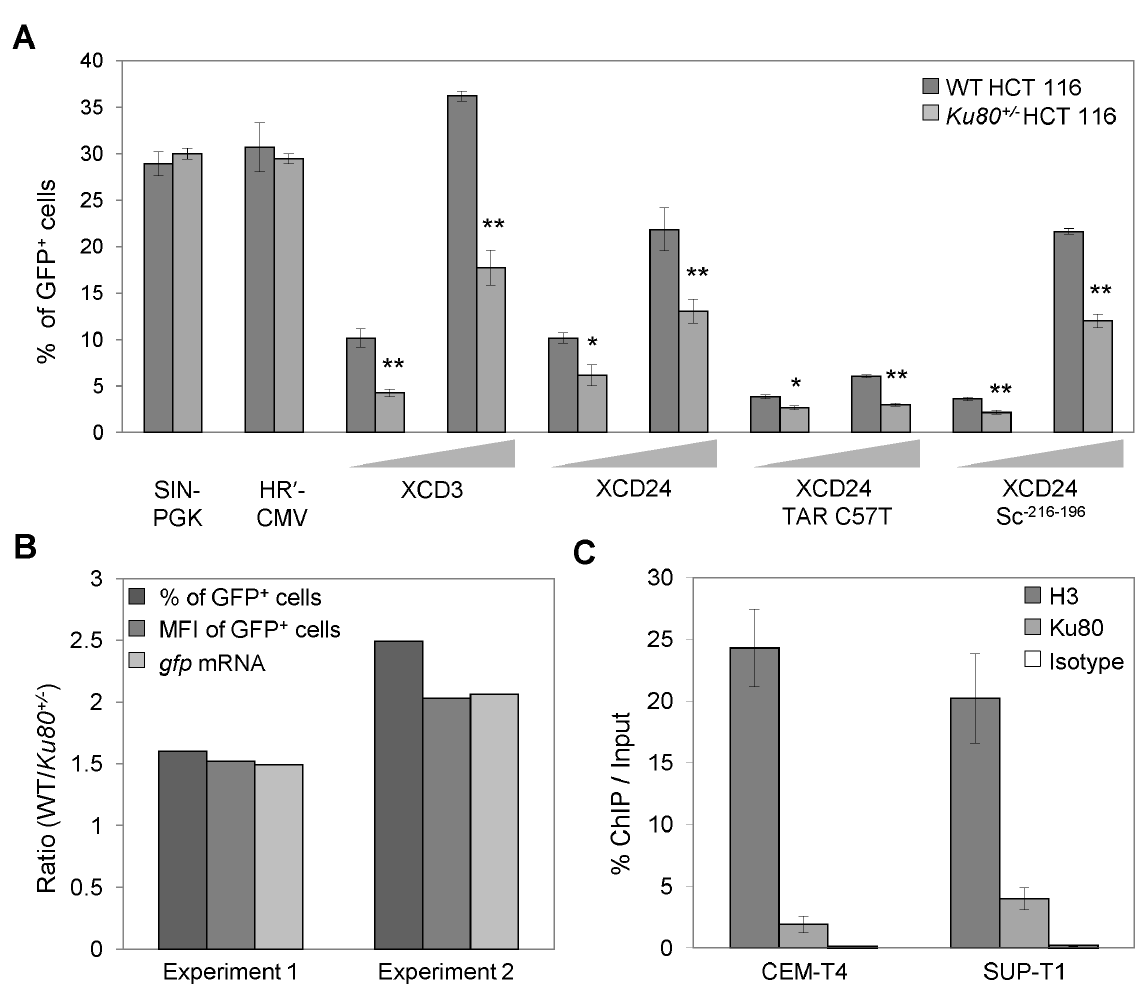
Figure 5. The level of Ku impacts specifically on the LTR-driven GFP transcription from HIV-1. ( A ) Wild-type (WT) and Ku80 + / 2 human colon carcinoma HCT 116 cells were transduced for 48 h at the depicted m.o.i. either with SIN-PGK, HR’-CMV, XCD3, XCD24 or derivatives of XCD24 in which the putative Ku-binding sequence (KBS) (XCD24 Sc -216-196 ) or the trans -activation response (TAR) RNA element [XCD24 TAR(C37T)] was mutated (for more details on vectors, refer to Figure 1 ). Thereafter, the percentage of green fluorescent protein-positive (GFP + ) cells was measured by flow cytometry. The results from at least 2 independent experiments are presented as mean 6 SEM (*, p , 0.05; **, p , 0.01), except for XCD24 Sc - 216-196 and XCD24 TAR(C37T) for which one representative experiment (of 2 independent observations yielding similar results) is represented (mean 6 SD). ( B ) WT and Ku80 + / 2 HCT 116 cells were transduced at mid m.o.i. ( , 0.5) with XCD3 and subjected 48 h later to either flow cytometric analyses to measure the percentage and the geometric mean fluorescence intensity (MFI) of GFP + cells or reverse transcription quantitative PCR (RT-Q-PCR) assays to quantify the gfp mRNA content (normalized to gapdh mRNA content). The ratios between WT and Ku80 + / 2 cells HCT 116 cells for the indicated parameters are illustrated. The results correspond to two representative and independent experiments. Of note, the percentages of GFP + WT cells in experiments 1 and 2 were of 15% and 25%, respectively. ( C ) Human T lymphoid leukemia (CEM-T4) and lymphoma (SUP-T1) cells were transduced for 48 h with human immunodeficiency virus type 1 (HIV-1) NL4.3 env - before chromatin immunoprecipitation (ChIP)-mediated assessment of the binding of Ku80 to the region of the HIV-1 long terminal repeat (LTR) and the leader region, which is located downstream of the LTR. The results are expressed as the fraction of immunoprecipitated DNA for each set of conditions (mean 6 SEM, n =2). H3, Ku and isotype correspond to conditions in which the DNA was immunoprecipitated by using specific antibodies against histone H3 or Ku80, or an irrelevant control antibody,